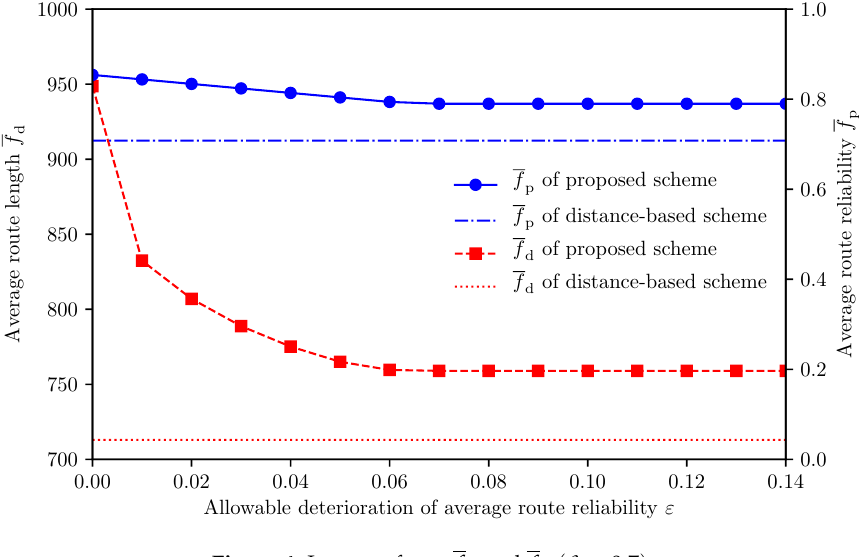
Figure 4. Impact of ε on f